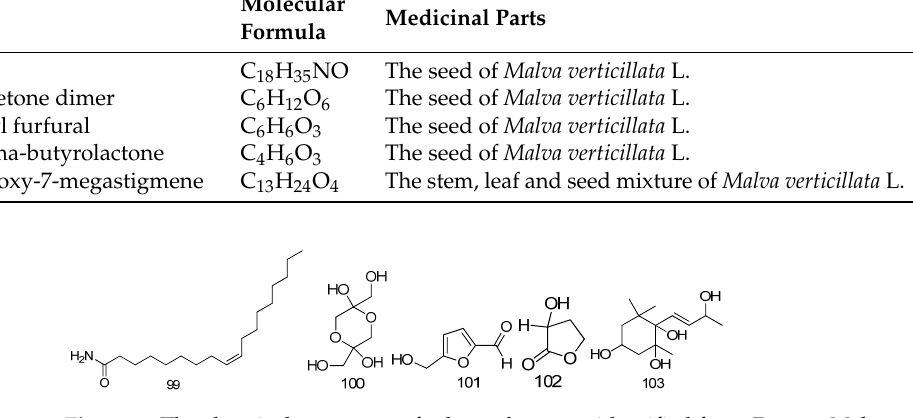
Table 8. The other substances identified from Fructus Malvae .